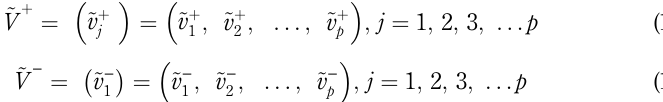
the lowest values for FNIS and highest values for FPIS for a criterion in the given column. Step 8: In this step, separation distances from FPIS and FNIS are calculated. There are various methods to calculate the separation measures each alternative to resolve grey relational coefficient of every alternative. Some of these method are: normalized Hamming distance ð l Þ ; normalized Euclidean distance ð h Þ , Hamming distance ð d Þ , Euclidean distance ð c Þ . This study is based on expansion of Burillo and Bustince ’ s technique (1996) to calculate grey relational coefficient based on the Hamming distance ð d Þ . The separation measures alternative are evaluated using Eqn. (11) and (12).